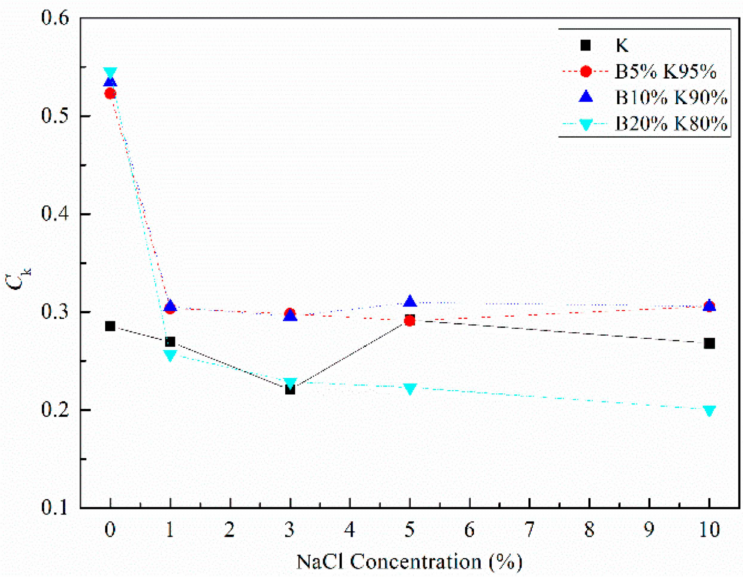
Figure 7. The parameter C k vs. NaCl